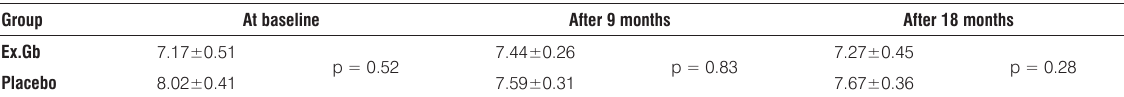
Table 1. Mean level of HbA1c (%) at baseline, after 9 and 18 months. There were no significant differences in the level of HbA1c at all measurements in both